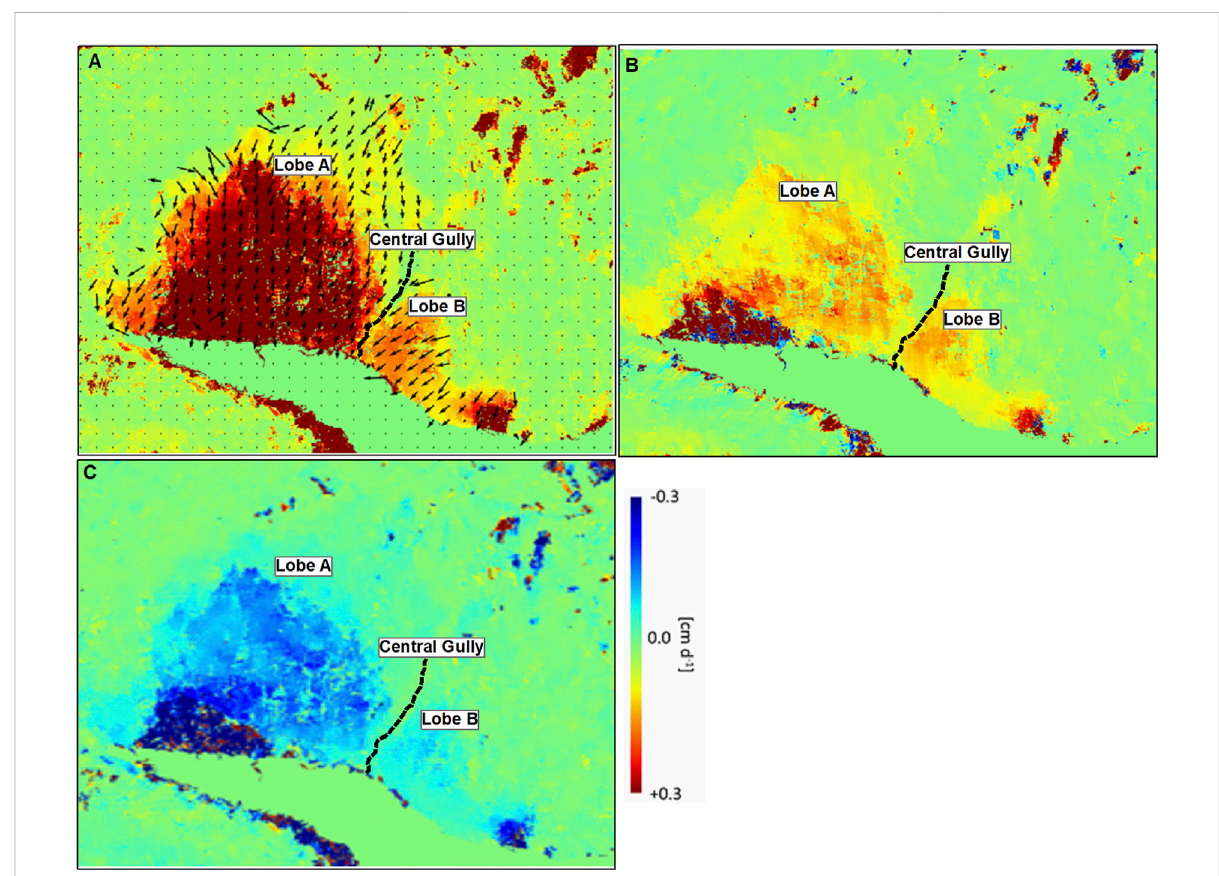
FIGURE 15 Three-dimensional displacements (ascending and descending orbit geometry SAR speckle tracking) versus one-dimensional displacements (only descending orbit geometry) over a 5-year period (2015-07-13 to 2020-08-03). (A) 3D velocity vectors indicating displacement magnitude (colourscale),map direction (arrow aspect),andplunge(arrow length). (B) InSAR1D projection of3Dvectorsalong thedescendingline-of-sight. (C) Vertical component of 3D velocity